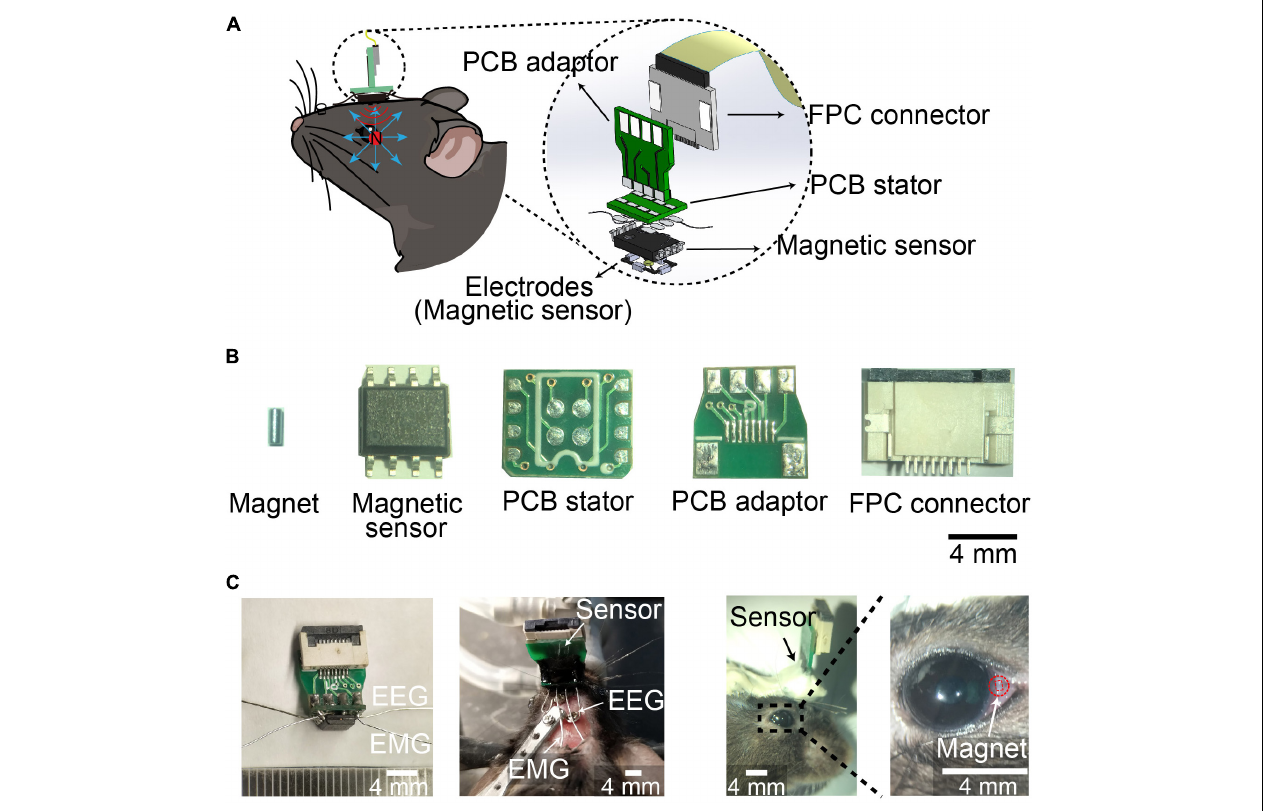
FIGURE 1 | Device for EEG, EMG, and eye movements recording during sleep. (A) Schematic of implanted device recording EEG, EMG and eye movements. (Left) device mounted on the head of mice with magnet implanted into conjunctiva. (Right) 3D Model showing the components of the device. (B) Photograph of magnet, magnetic sensor, PCB stator, PCB adaptor, and FPC connector. Scale bar, 4 mm. (C) Photograph of the device (Left) , head-mounted device with electrodes implanted in mice (middle) , and magnet implanted into conjunctiva (Right) . Red square indicated the outline of magnet implant. Scale bar, 4